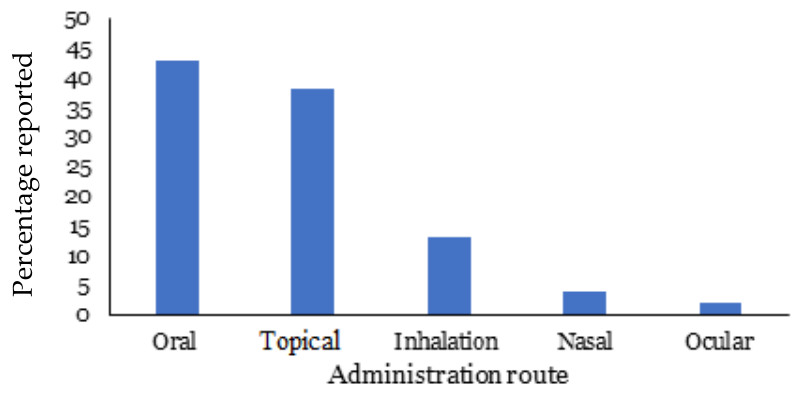
Figure 3. Most common methods for the administration of herbal medicines.